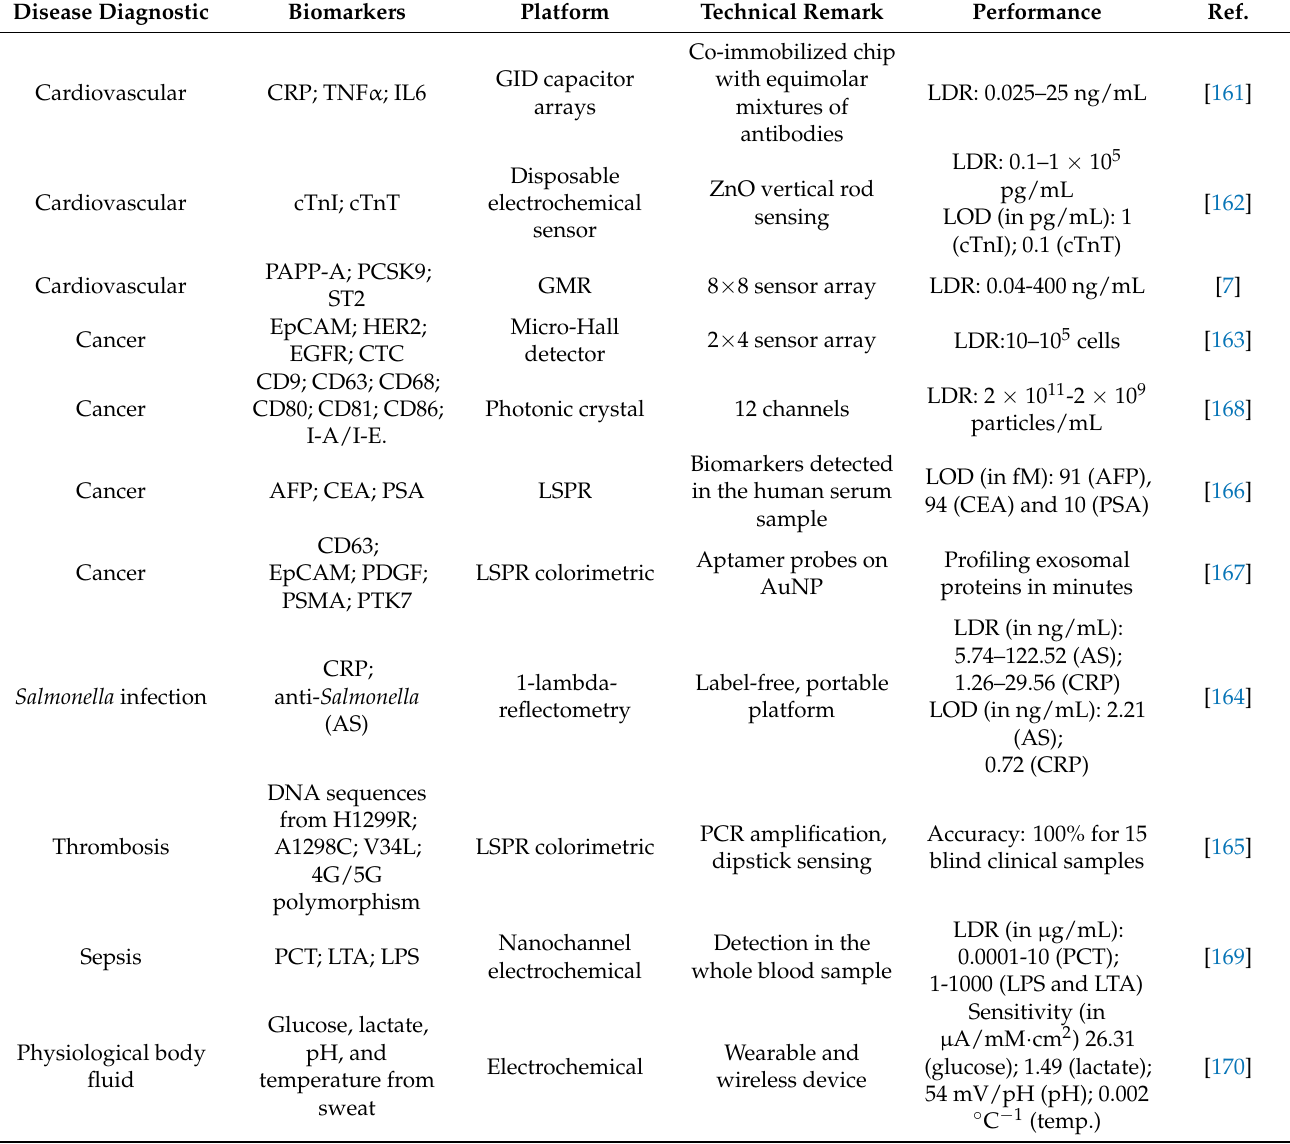
Table 6. Summary of biosensor studies for multiplex detection of